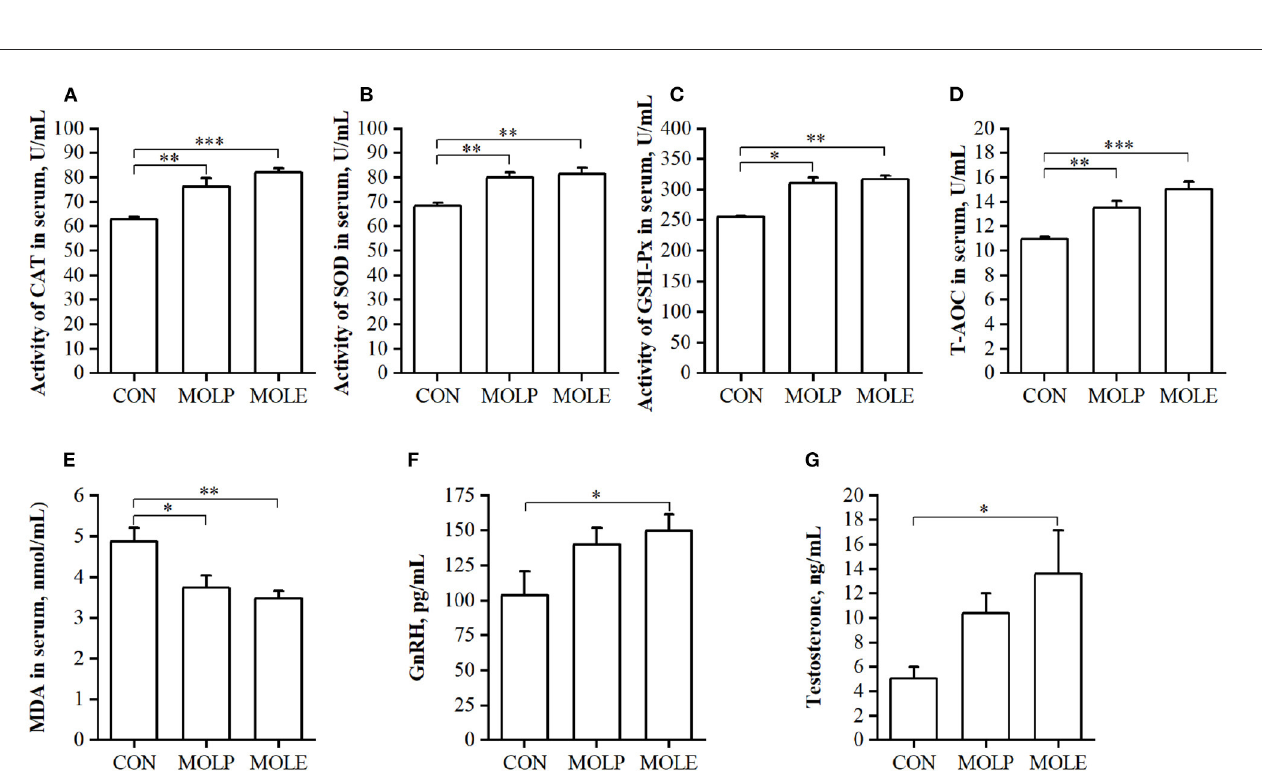
FIGURE2 Effect of MOLP and MOLE supplementation on serum antioxidant capacity and reproductive hormone of cashmere goats. (A) CAT; (B) SOD; (C) GSH-Px; (D) T-AOC; (E) MDA; (F) GnRH; and (G) Testosterone. The values in the histogram are the means ± SEM, * P < 0.05; ** P < 0.01; *** P < 0.001. CON, Control; MOLE, Moringa oleifera leaf ethanolic extract; MOLP, Moringa oleifera leaf powder; CAT, Catalase; SOD, Superoxide dismutase; GSH-Px, Glutathione peroxidase; T-AOC, Total antioxidant capacity; MDA, Malondialdehyde; GnRH, Gonadotropin releasing